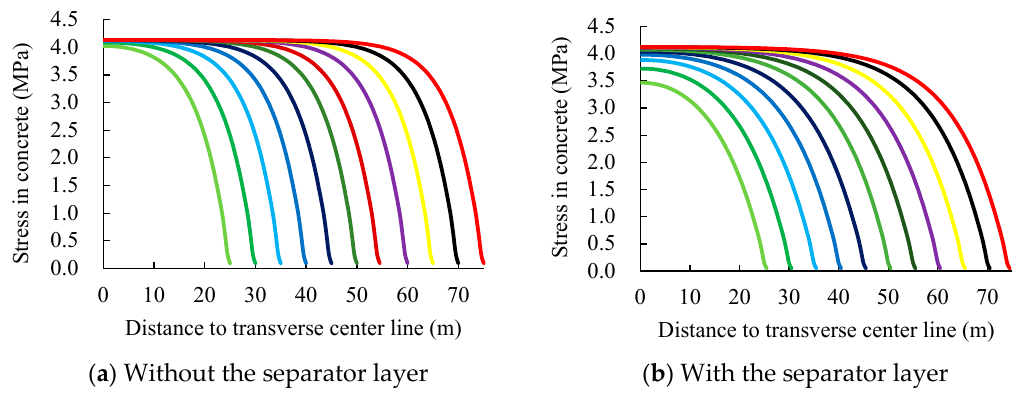
Figure 14. Contraction stress of concrete with different paving lengths.